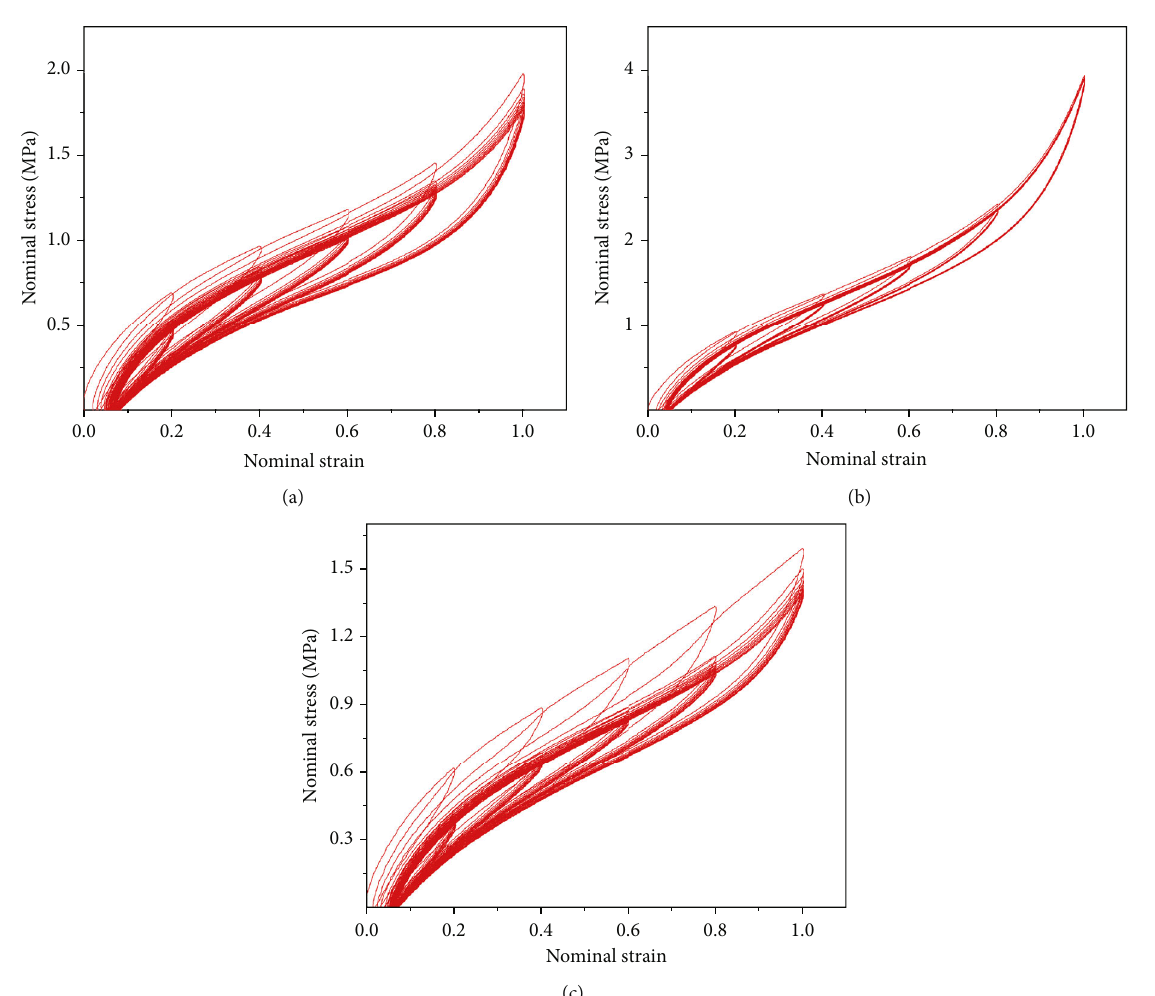
Figure 3: Stress-strain cycle stretch curve under fi ve strains of (a) Tread rubber, (b) Body rubber, and (c) Side rubber.